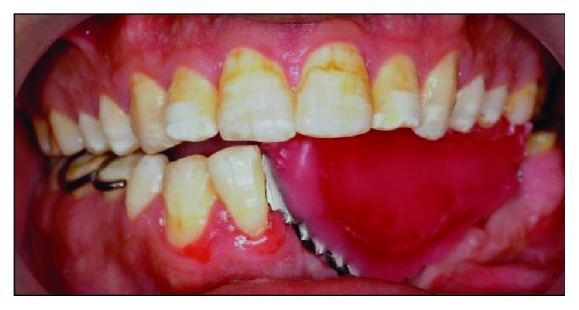
Wax bite record.